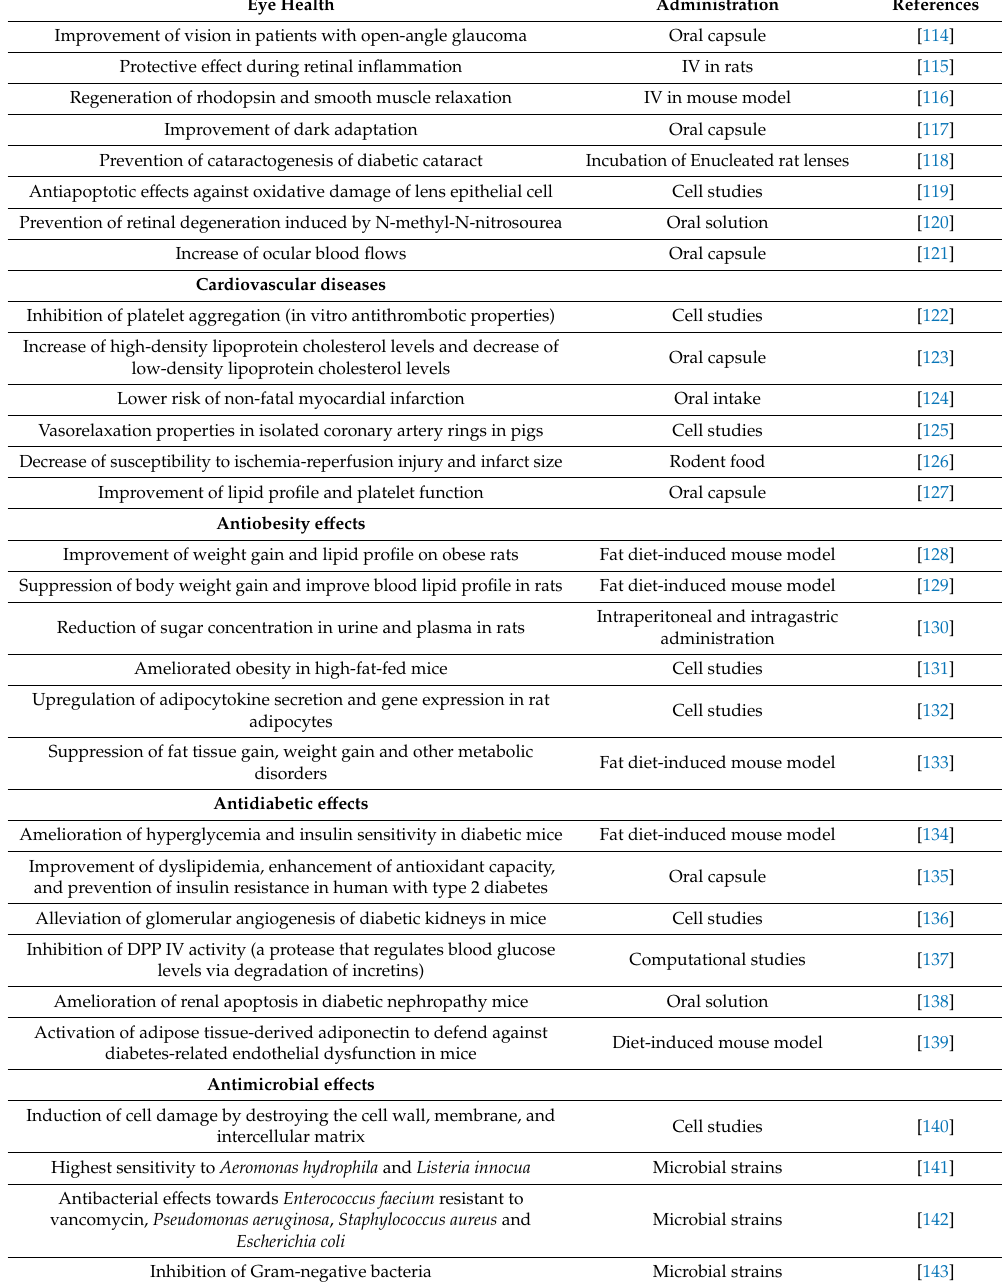
Table 3. Health benefits of